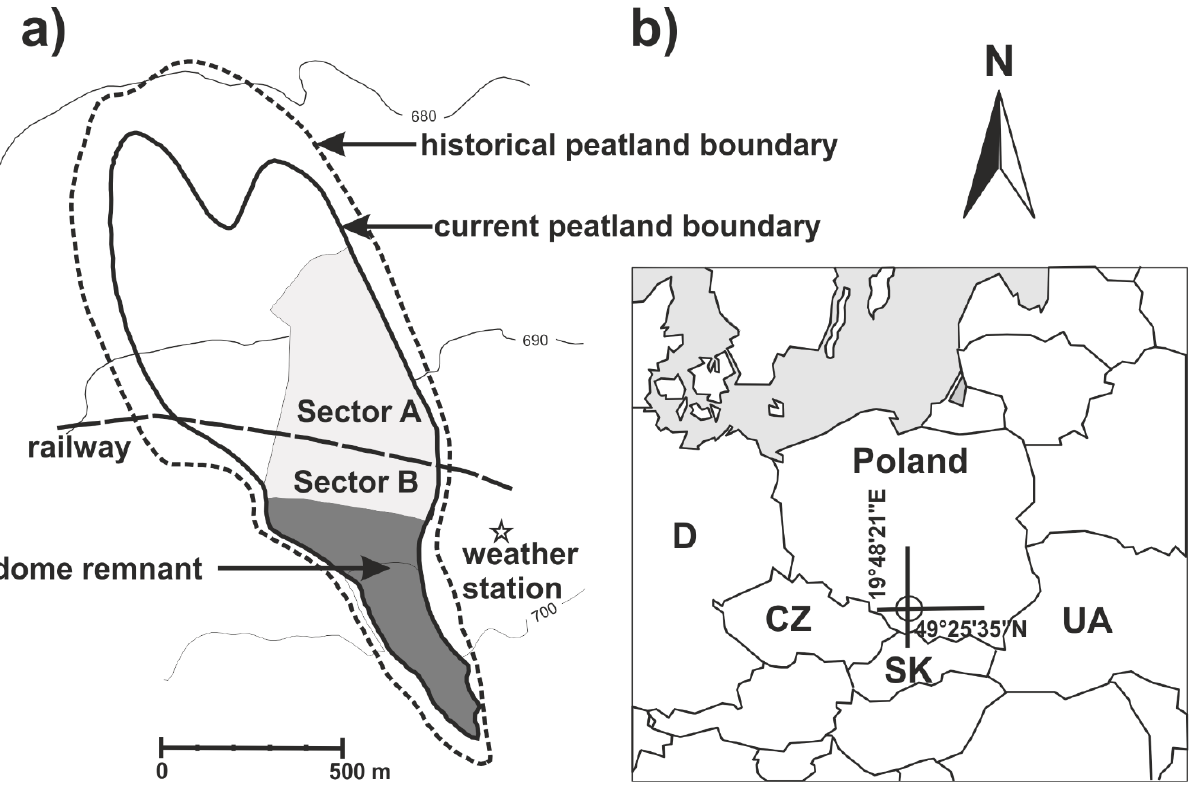
Figure 1. Map of the Bór za Lasem peat bog showing the two investigated sectors of the extracted area (adapted from Łajczak 2006) (a), and location map